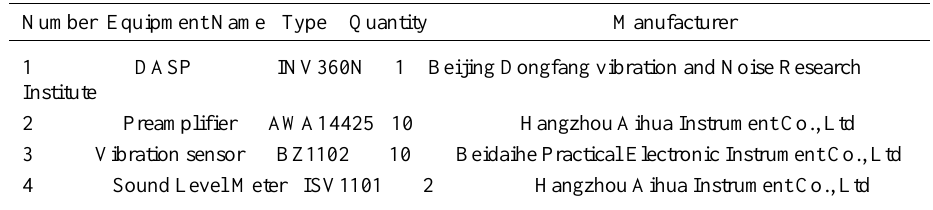
Table 2. List of the test equipment